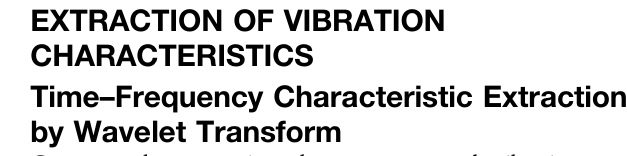
Frontiers in Built Environment |